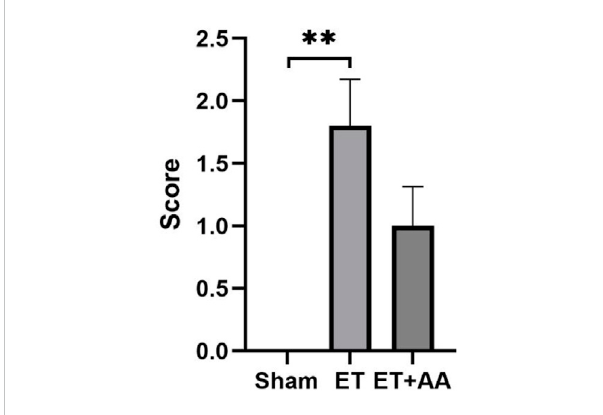
FIGURE 8 Histopathology scores of the kidneys in the sham, ET, and ET + AA groups. Values are expressed as mean ± SEM, n = 5.